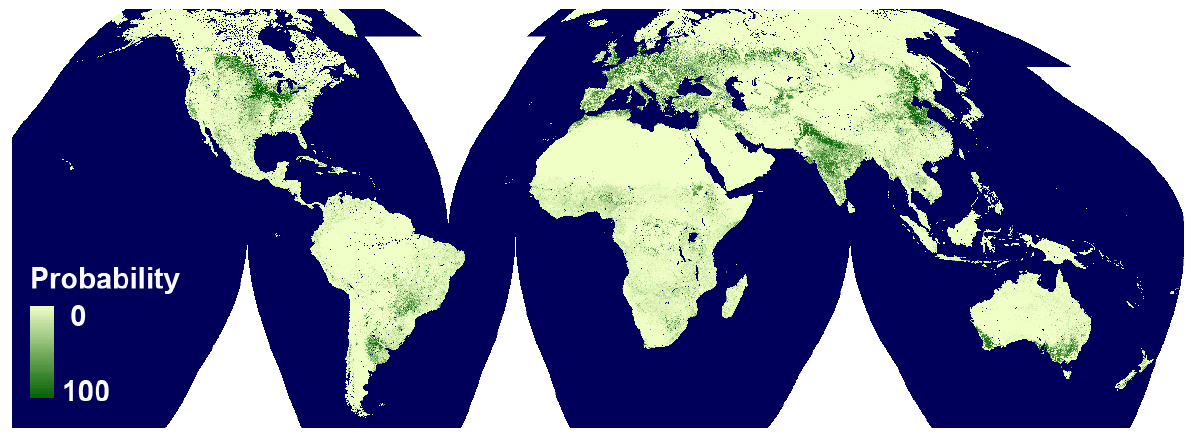
Figure 7. Dynamic 250 m Global Croplands